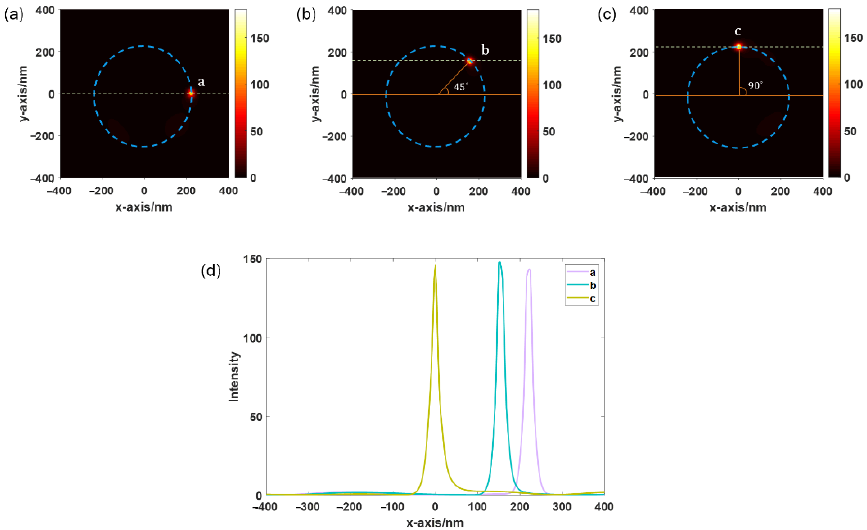
Figure 8. Distribution of local electric field strength when the probes are located above the SPP vortex and the angle between the line between the point on the vortex and the center of the vortex and the x-axis are ( a ) 0 ° , ( b ) 45 ° , and ( c ) 90 ° . The circular dotted line indicates the shape of the SPP vortex. ( d ) Distribution of the local electric field along the dashed line in the three cases.